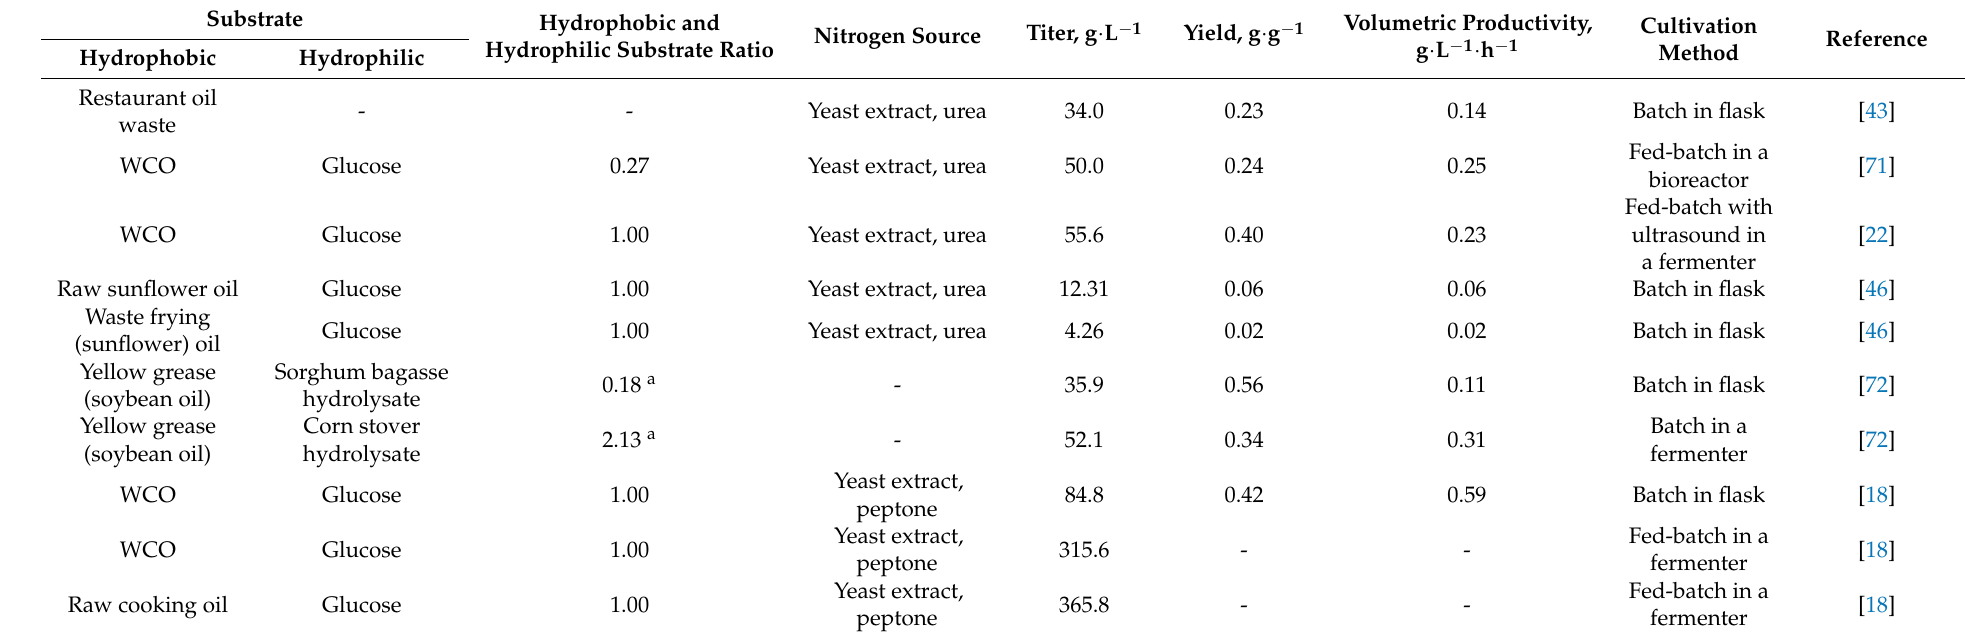
Table 2. Production of sophorolipids from WCO and raw vegetable oil by yeast Starmerella bombicola